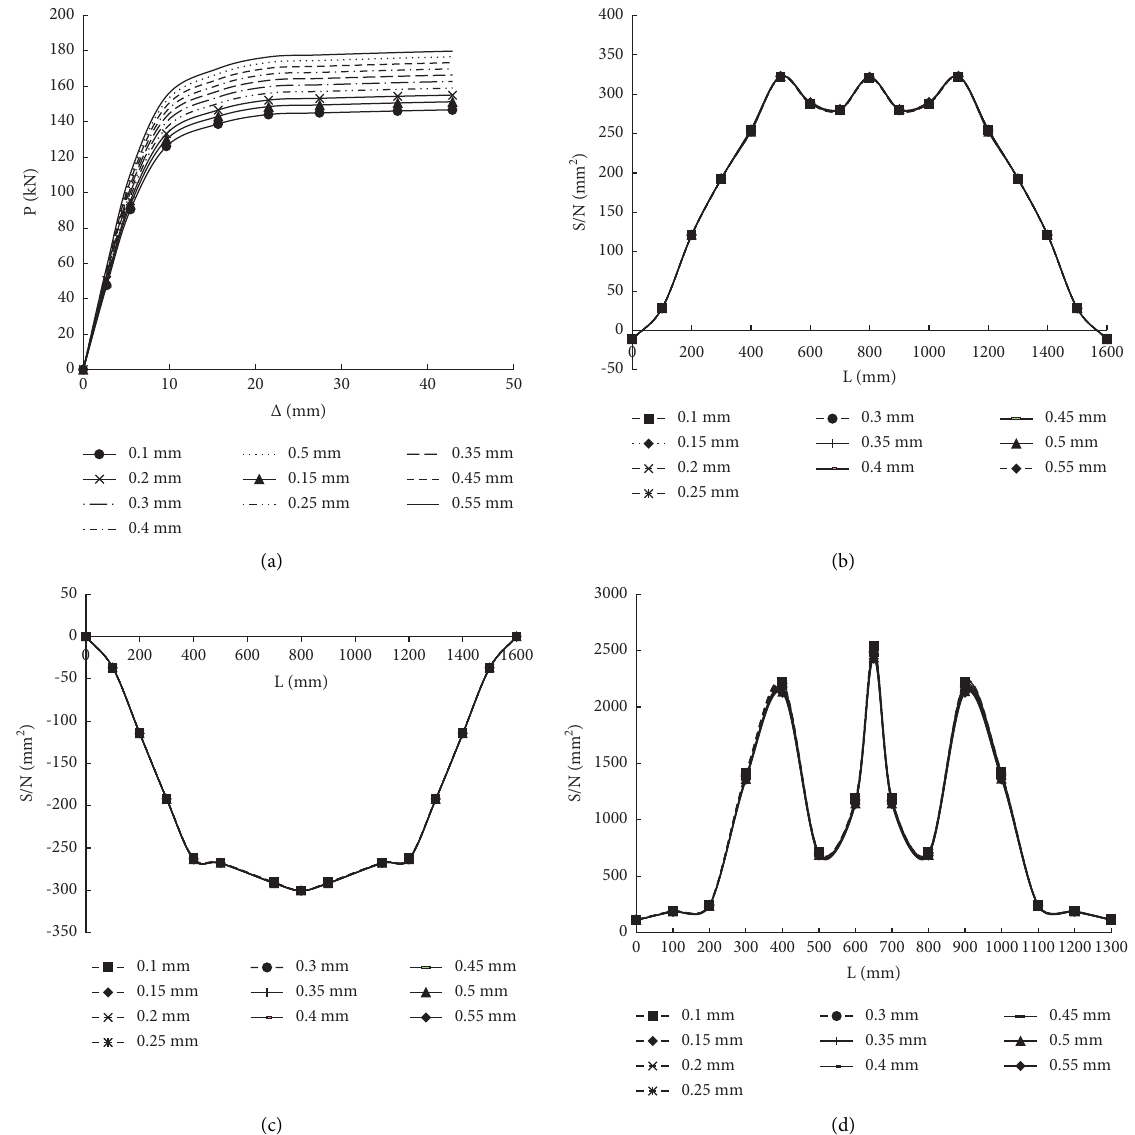
Figure 18: Effect of CFRP sheet’s thickness. (a) Load and deflection. (b) Stress along steel beam length. (c) Stress along steel beam width. (d) Stress along CFRP sheet’s